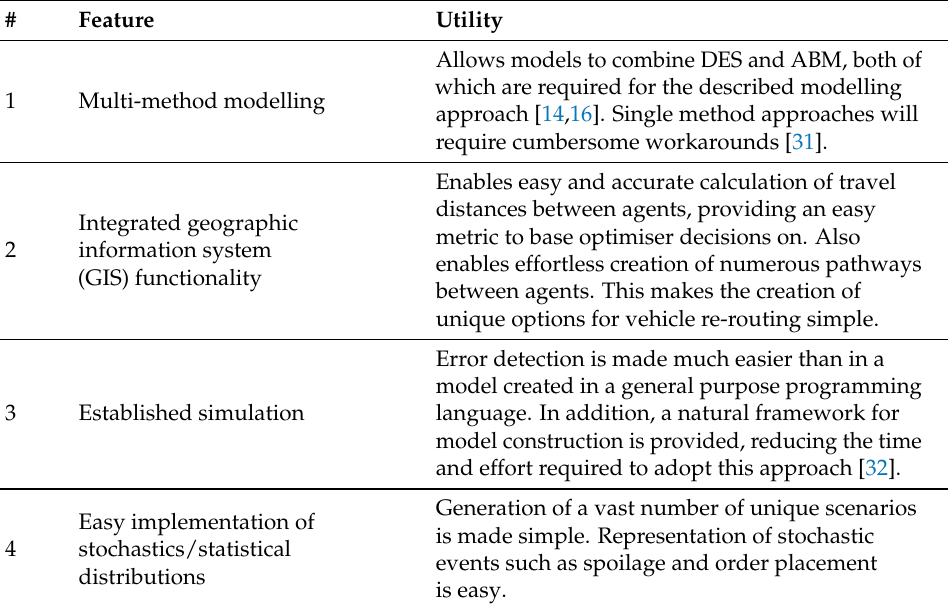
Table 1. The benefits of AnyLogic as the simulation package used for this work.